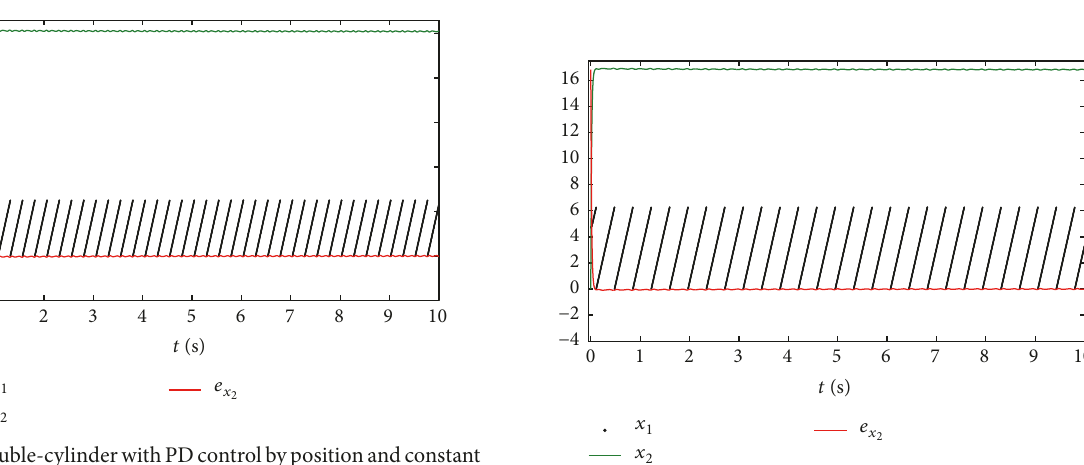
Figure 10: PD control signal for constant velocity ( 𝑥 2∗ = 25.245 rad/s = 30km/h) with double-cylinder excited by pressure (normalized).